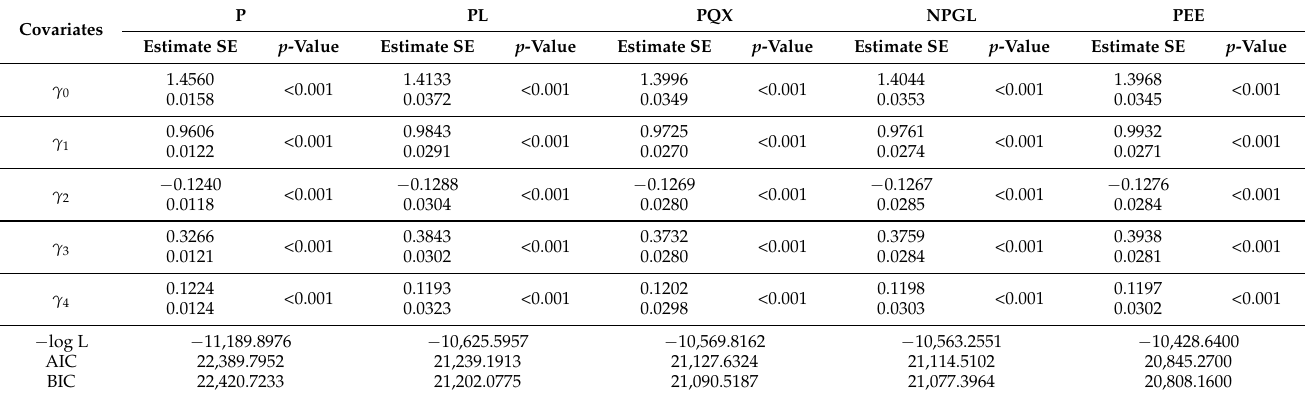
Table 10. The MLE, − log L, AIC and BIC of the fitted regression models for the length of stay data set. PL PQX NPGL PEE Covariates Estimate SE Estimate